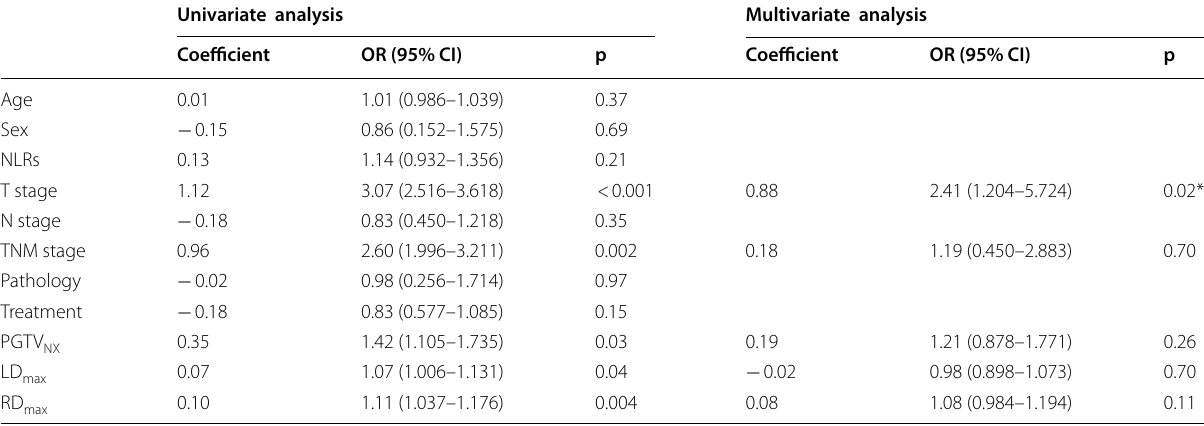
CI confidence interval, LD max = volume included the primary nasopharyngeal tumor or enlarged retropharyngeal nodes, RD max metastasis. * indicates significant